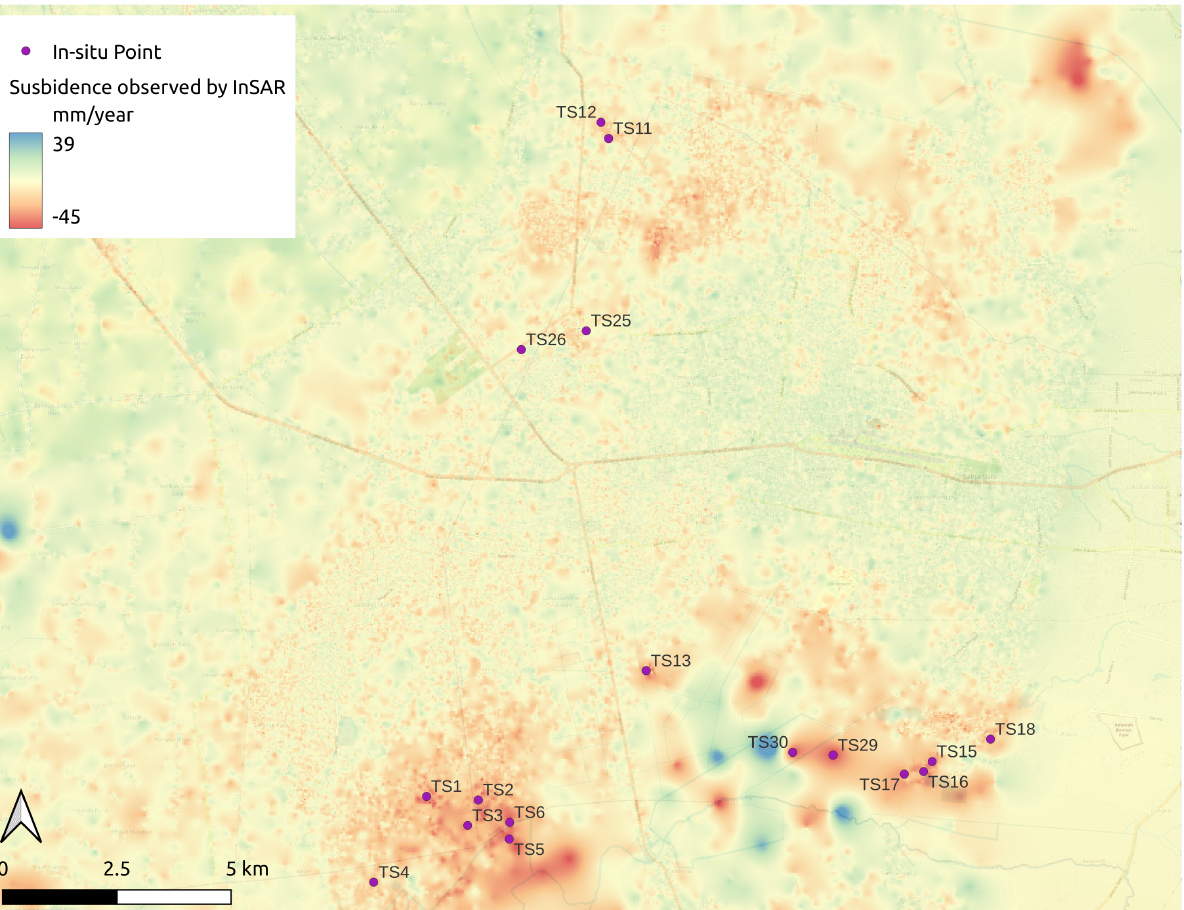
Figure 4. Map of subsidence rate in Banjar Regency and Banjarbaru City, South Kalimantan, Indonesia and its surroundings observed by Sentinel-1 Descending SAR data from 2019 to 2020.